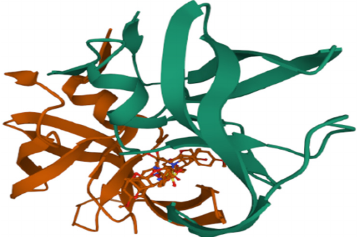
Processes 2022 , 10 , x FOR PEER REVIEW Figure 3. The PID is a crystal of the HIV-1 protease complex of the 5COP. Figure 3. The PID is a crystal of the HIV-1 protease complex of the 5COP.